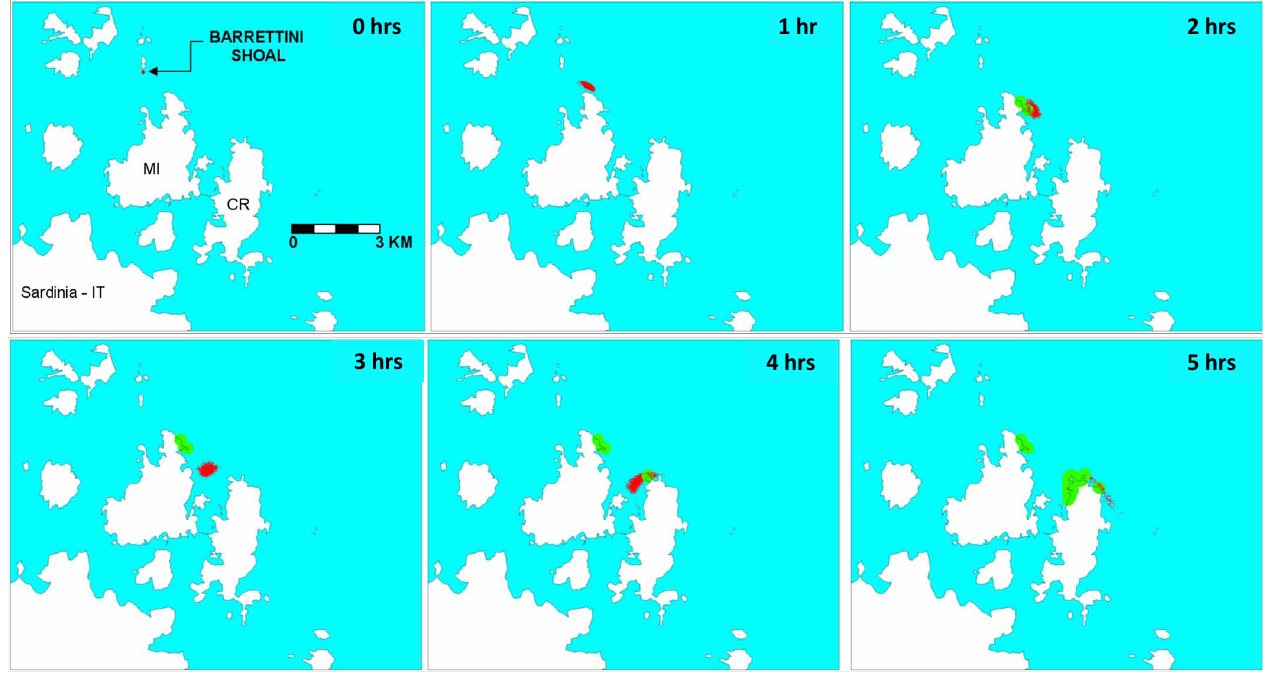
Fig. 8. Snapshots of oil particles distribution dispersed in the water (red dots) and beached on the shore (green dots). Figure 9